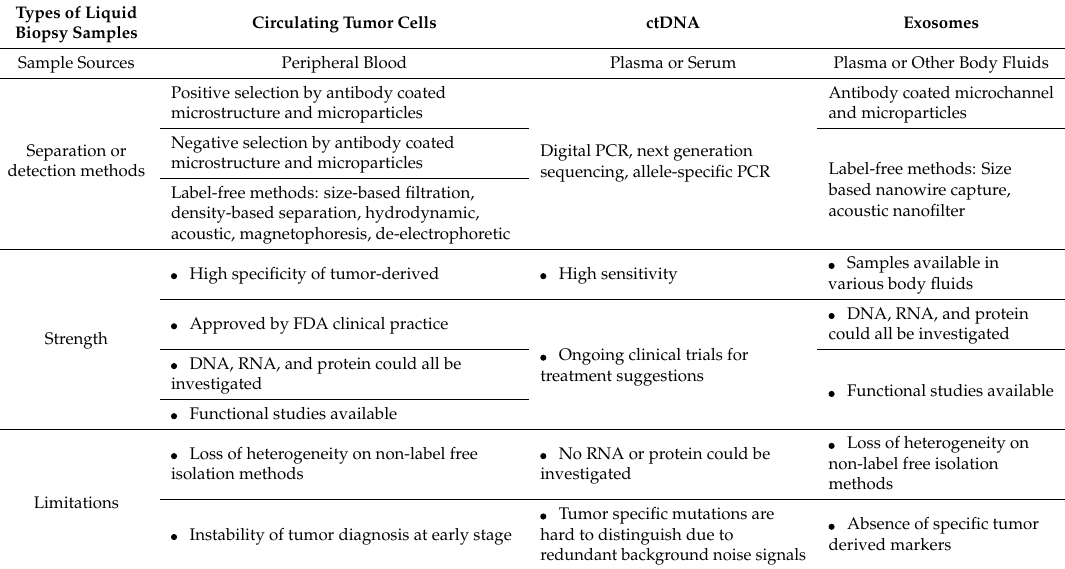
Table 1. Comparison of three liquid biopsy methods (circulating tumor cells [CTCs], circulating tumor DNA [ctDNA], and